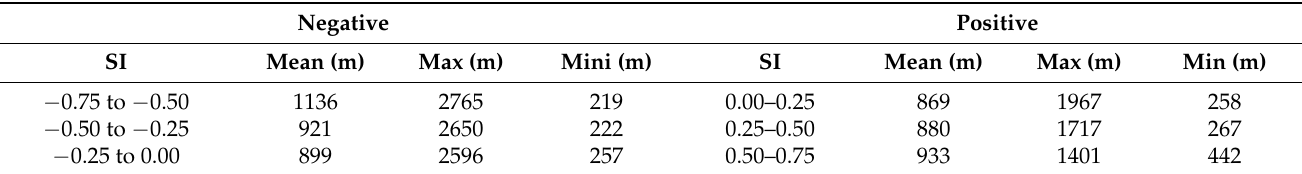
Table 4. Statistics of altitude in different sensitivity index (SI)